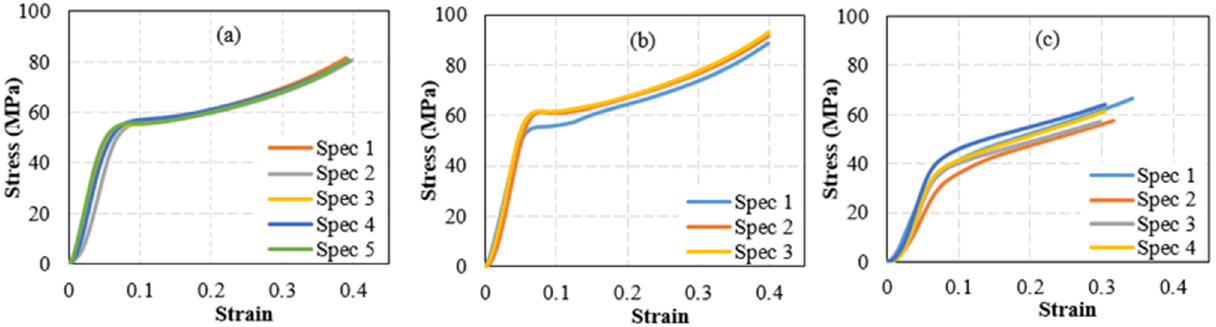
Figure 15. Stress-Strain curves of 3D printed PLA-sand compression cylindrical specimens. Subfig- ures ( a – c ) correspond to the sand weight fractions of 0, 0.5, and 15 wt%, respectively.